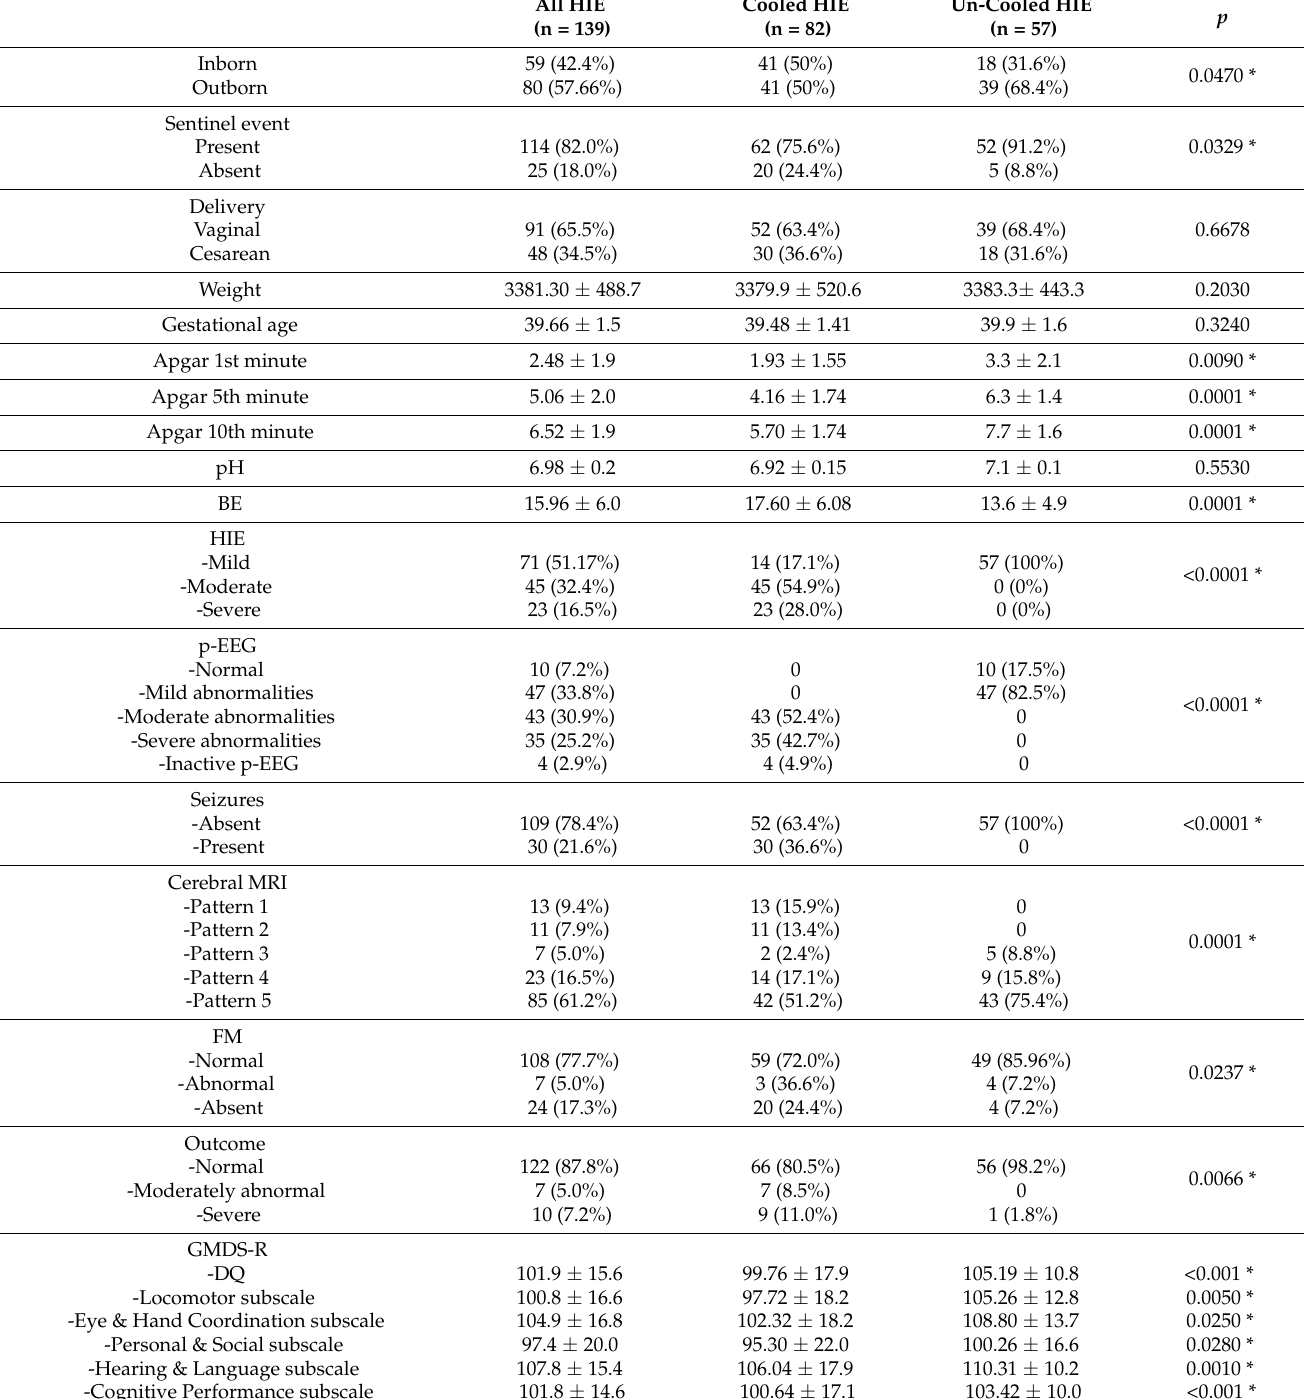
Table 1. Comparison of cooled and un-cooled asphyxiated